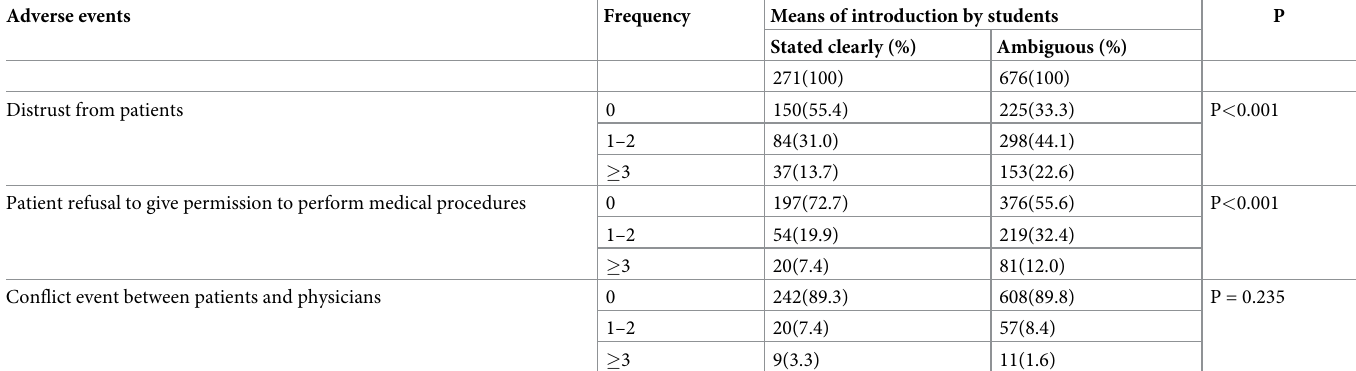
Table 2. Adverse events encountered by medical students according to how they introduce themselves to patients. Adverse events